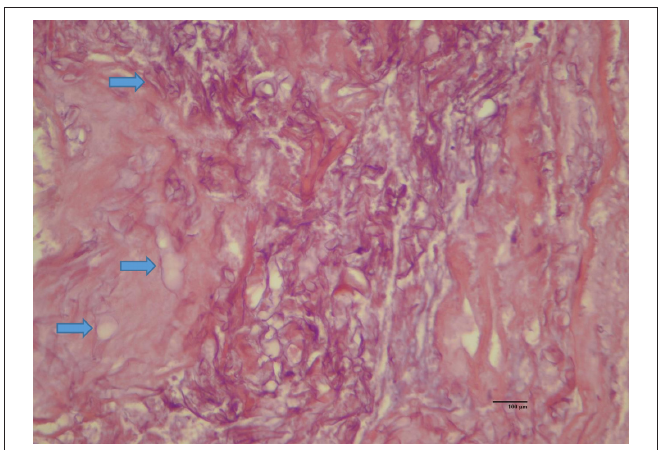
Figure 3. Numerous fungal structures are widely distributed and irregularly distributed. A few septa are indicated by arrows. (we need details about